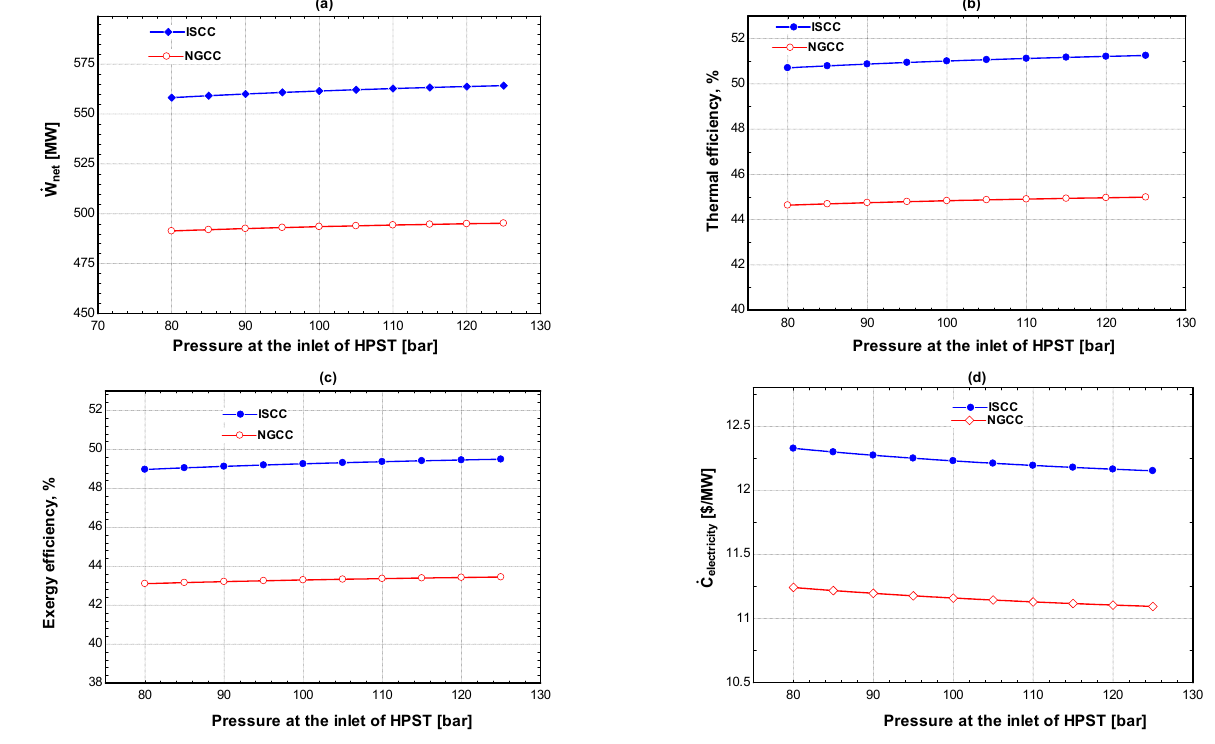
Figure 5. The effect of pressure at the inlet of HPST (P HPST, in ) on the overall performance and cost of both systems: ( a ) the total produced power, ( b ) thermal efficiency, ( c ) exergy efficiency, and ( d ) total rate of production costs.